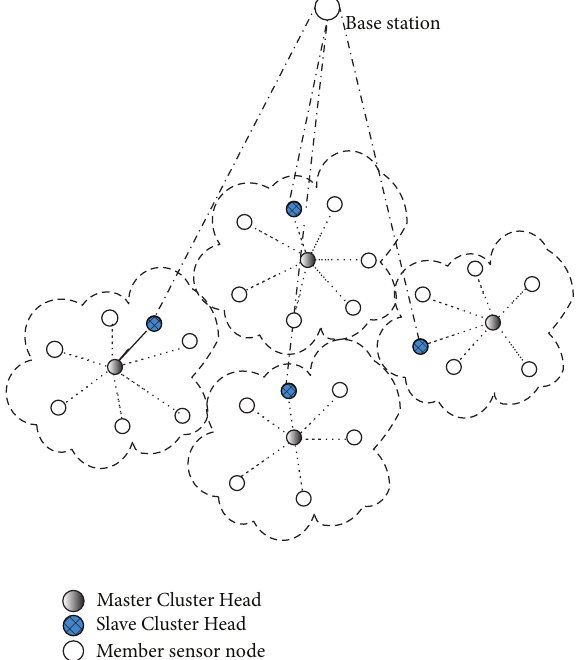
Figure 1: DCH-NPSO partial network